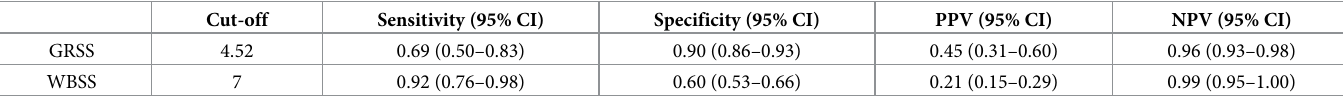
Table 3. Values of the Global Respiratory Severity Score and the Wang bronchiolitis severity